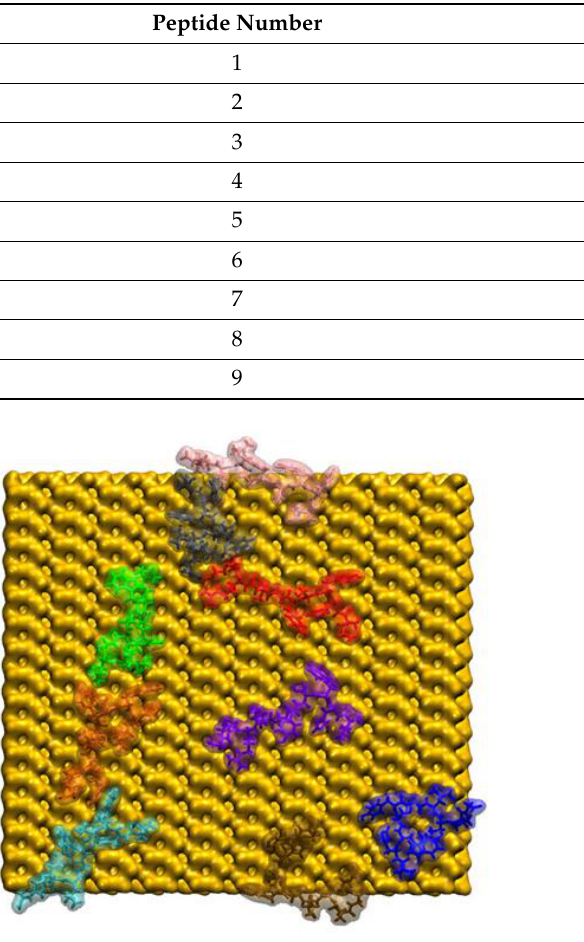
Figure 1. Simulated GnRH-I structure in solution using a transparent surface overlapped on the liquorice representation in VMD. Positive side chains are shown in blue, negative in red, and neutral in grey, and Arg8 is annotated. Table 1. Peptide colour scheme used in Figures 2–6.